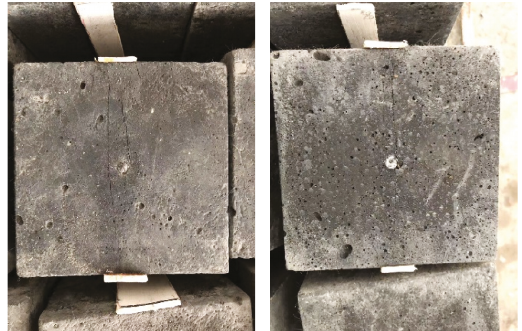
Figure 10: Appearance of split tensile failure